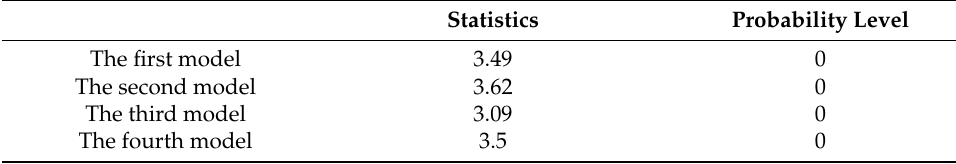
Table A3. The integration test results.